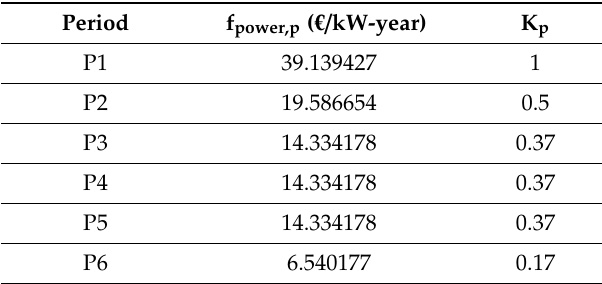
Table 1. Data on demand charges